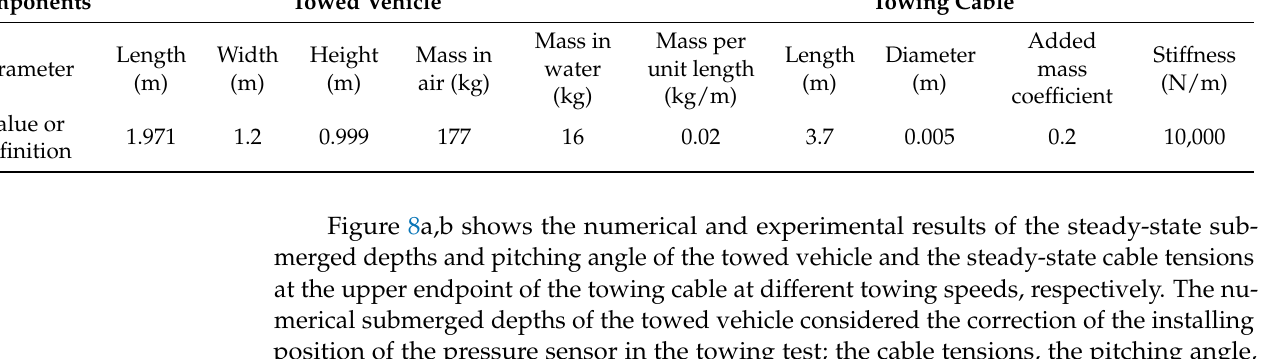
Figure 8. Steady-state numerical and experimental results: ( a ) submerged depths and pitching angles; ( b ) towing forces. 5. Simulation Results and Discussion It can be seen from the results in Figure 8 that it was feasible to simulate the under- water towed system by the numerical method mentioned above. In this section, the verti- cal trajectory tracking in head waves of the complete towed system, as is shown in Figure 1, was numerically simulated. In the simulation, the wave height was 0.5 m, the wave- length was 36 m, and the forward speed was 5 kn; K p = − 0.045, K i = − 0.000015, K d = − 8.5. At t = 0 s, the towed vehicle was freely suspended in still water, and the towing cable drooped naturally; when 0< t ≤ 100 s, the shifting weight was held at L = 0 m, and the towed vehicle was towed uncontrollably until it reached a stable state; t > = 100 s, depth tracking control was initiated. There were three stages in the depth tracking control, that is, Stage I: tracked the target Z 0 = − 14.5 m in the period of 100 s< t ≤ 200 s; Stage II: tracked the target Z 0 = − 17.0 m in the period of 200 < t ≤ 300 s; Stage III: tracked the target Z 0 = − 18.0 m in the period of 300 s < t ≤ 400 s.